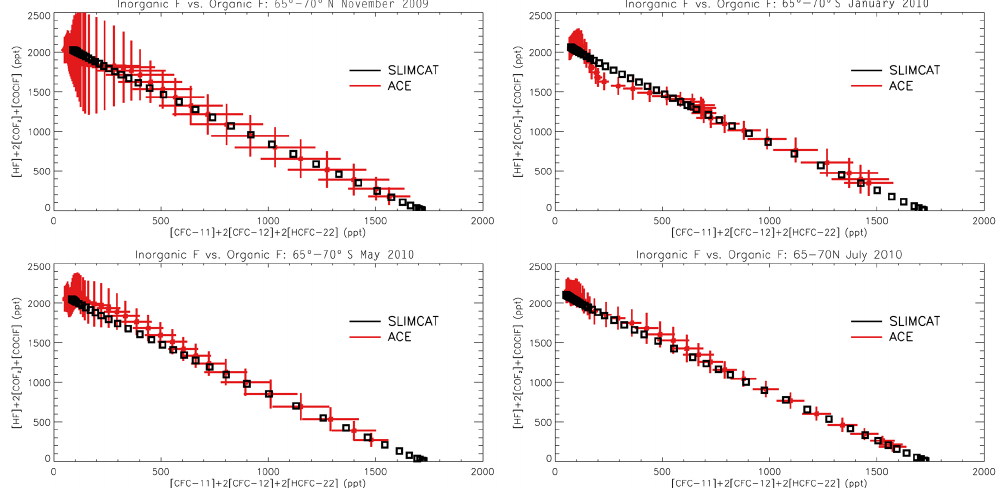
Figure 6. Correlation plots between coincident ACE-FTS observations and SLIMCAT calculations of total “major” organic fluorine, based on CFC-11, CFC-12, and HCFC-22, and total inorganic fluorine, F y , for November 2009/July 2010 65–70 ◦ S and January/May 2010 65–70 ◦ N. The error bars represent the standard deviations in the ACE-FTS